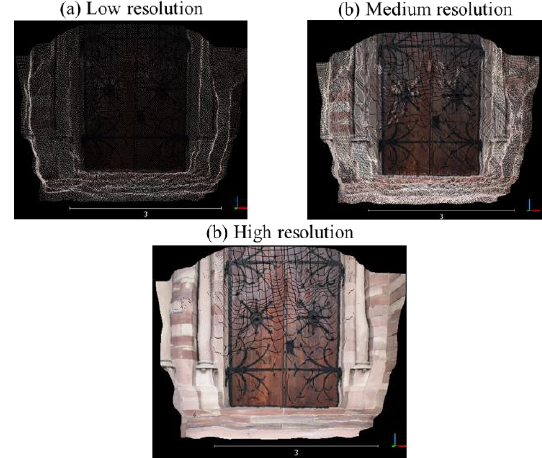
Figure 7. RGB-D resolution impact on point